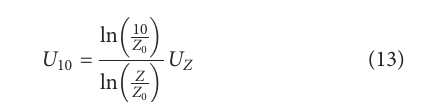
obtained 360 samples by breaking these data down into 10- minute averages. The experimental area and the actual drift trajectories of the lifeboats during the experiments are shown in Figure 4. It contains trajectories of walkaround observation and trajectories that are not under walking observation (tracking only the positions). The red line indicates the trajectory of the fi rst lifeboat drift experiment conducted on April 4, 2019, with a tracking observation time of about 24 hours. The yellow line indicates the trajectory of the second lifeboat drift experiment conducted on April 6, with a tracking observation time of about 24 hours, and the green line indicates the trajectory of the third lifeboat drift experiment conducted on April 9, with a tracking observation time of about 20 hours.